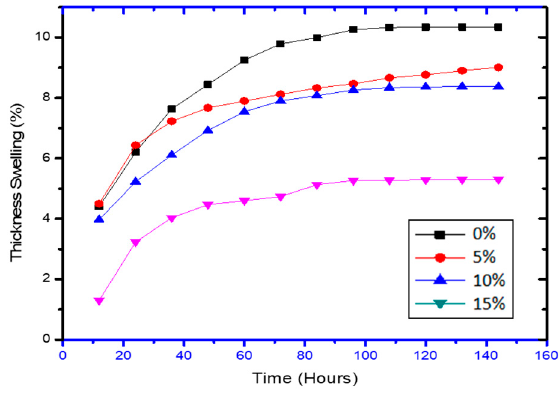
Figure 9. Thickness swelling properties of graphite-loaded composites.